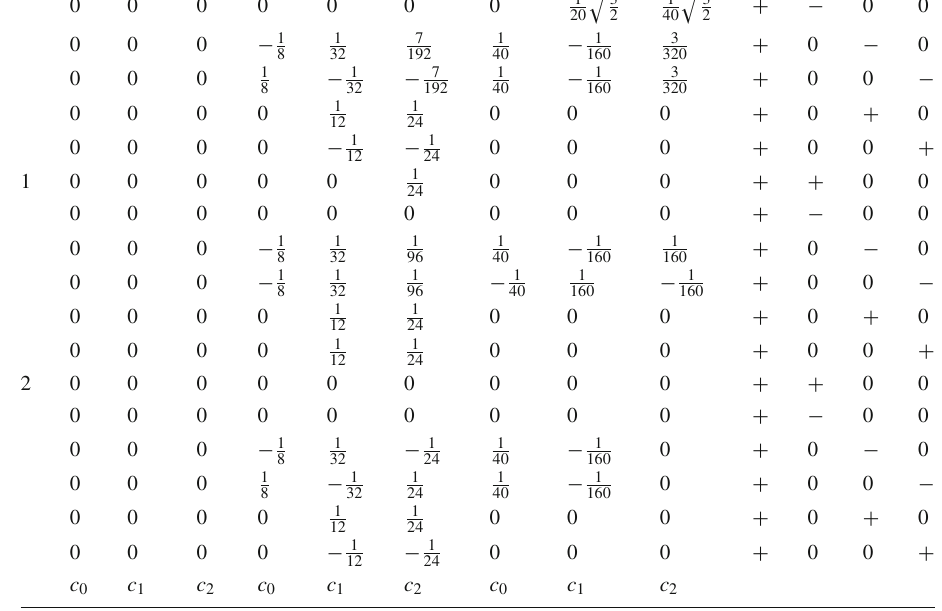
isospin-spin amplitudes calculated with Eq. (14) for the transversal operators L T i depending on the helicity of the incoming and outgoing particles. The isospin-spin amplitudes are given by A ij ( s ; λ ) = ( c + c + c ) g 4 s 0 F T 0 1 F T 1 2 F T 2